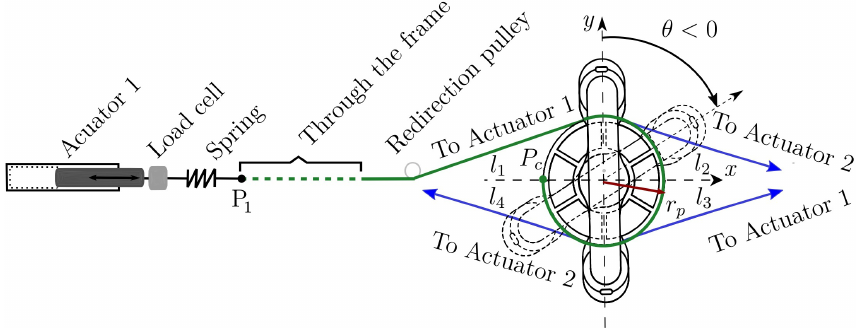
Figure 3. Handle and pulley-actuator interconnection.